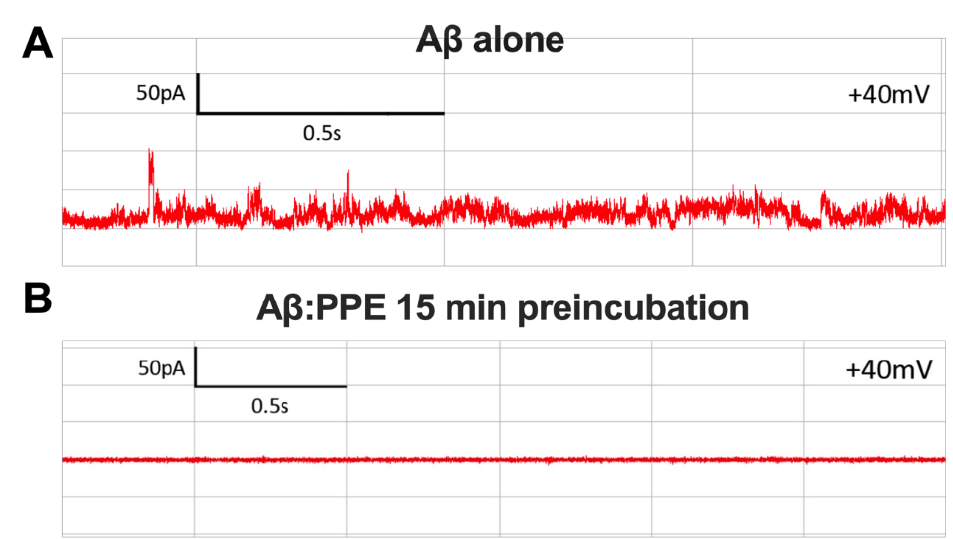
Figure 4. Padina pavonica extract prevents amyloid pore electrical activity. Planar lipid bilayer (45 PC/25 PE/10 PI/5 PS/15 CL) electrical recordings showed multilevel conductance events when oli- gomeric preparations of 0.5 μM Aβ42, 1 μM α -syn and 0.4 μM tau were exogenously added to the test chamber— a representative trace of Aβ42 amyloid pore cu rrent activity is illustrated in ( A ). Remarkably, a 15-min preincubation of the oligomers with PPE (1 μg/mL) prior to membrane in- troduction completely prevented ionic flux across the mito-mimetic planar bilayer for 2+ h of re- cording ( B ). Symmetrical KCl buffer (250 mM) solutions were used in the cis and trans chambers, with voltage- clamping at +40 mV.